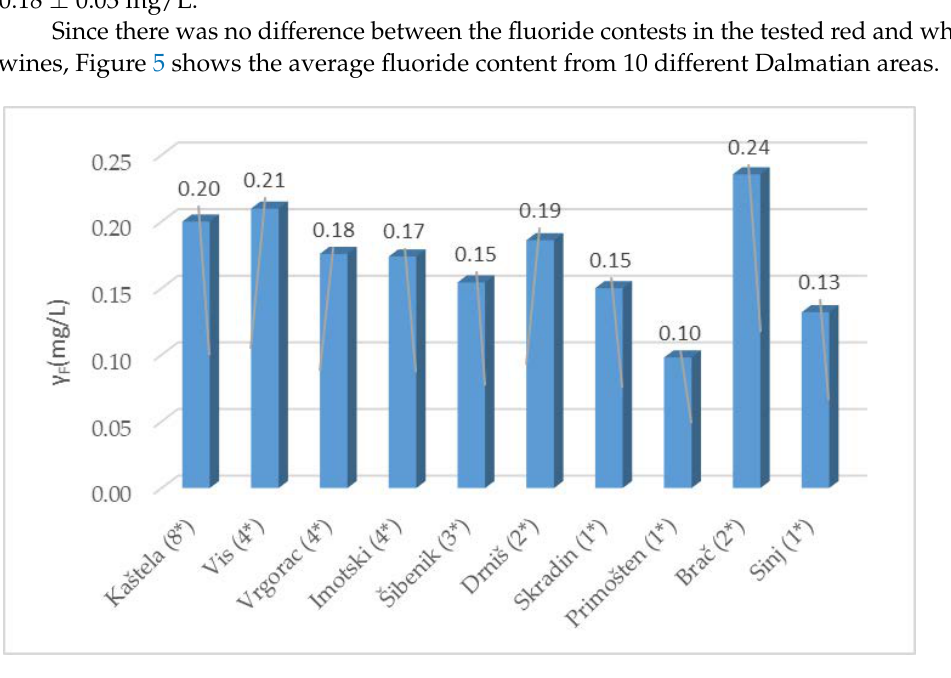
Figure 5. Mean mass concentration of fluoride depending on the vineyard origin; (*) number of different tested wine samples.